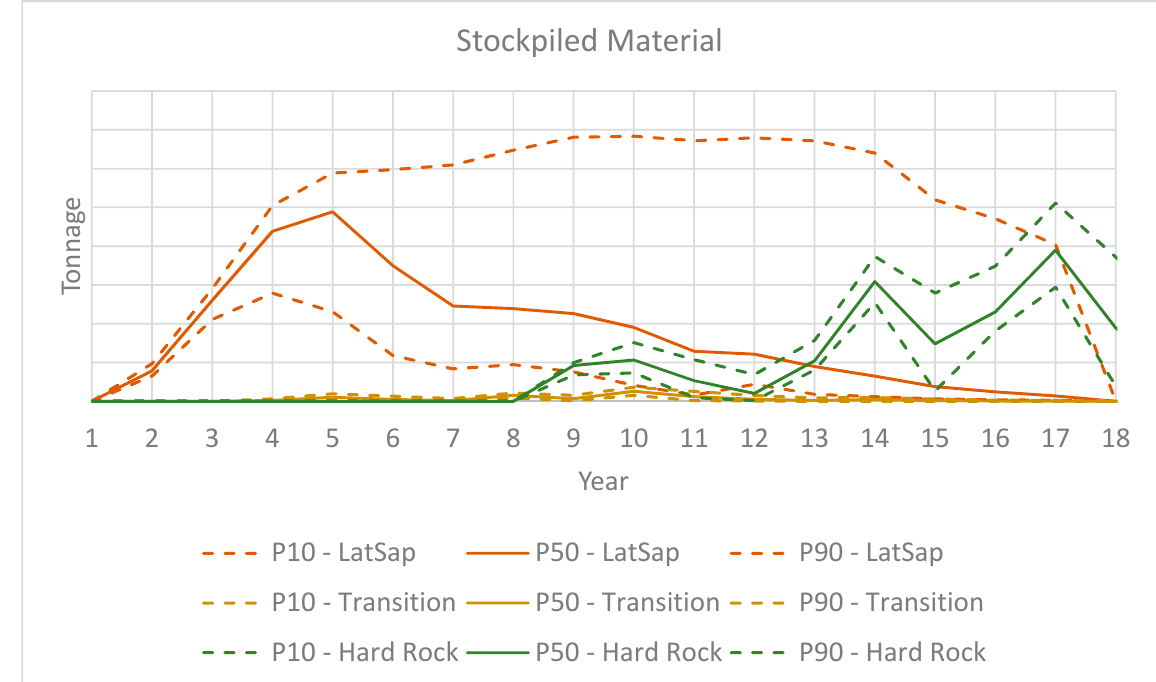
Figure 9. Stockpiled material at the RGM mining complex.